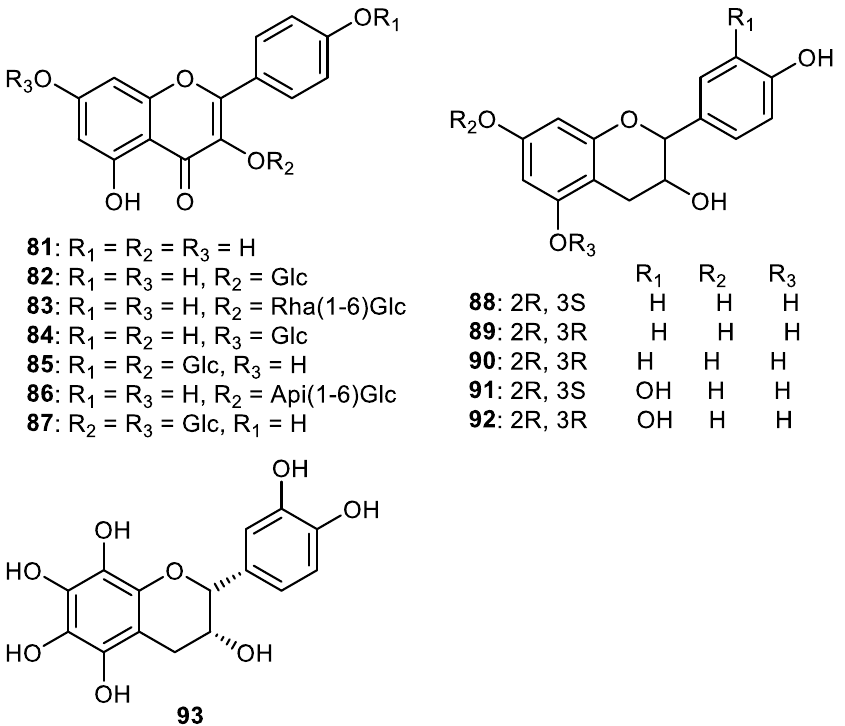
Figure 11. Structures of flavonoids 81 – 93 .